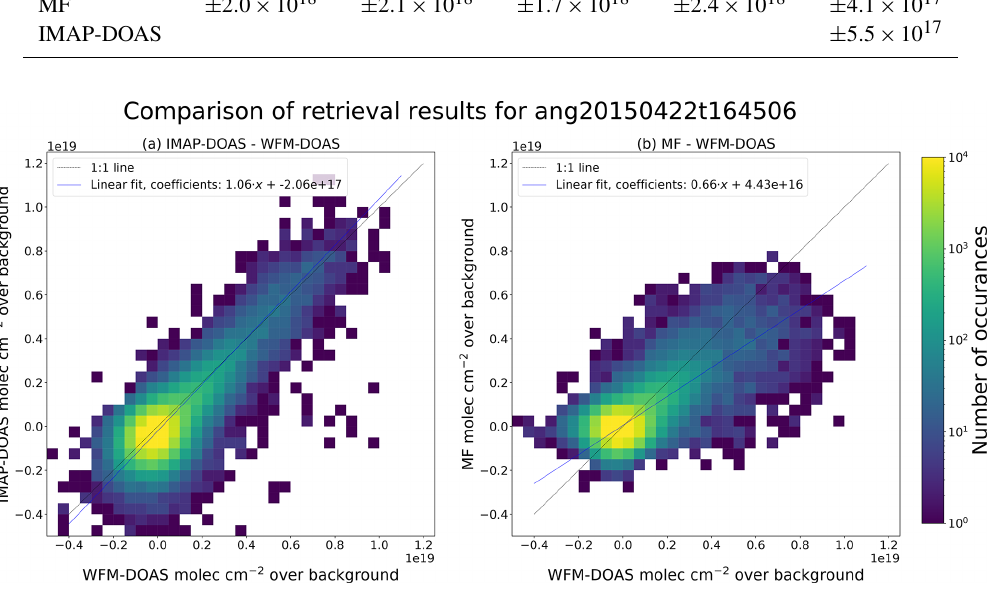
Figure 11. Scatter plot comparison between IMAP-DOAS and WFM-DOAS (a) and MF and WFM-DOAS (b) , respectively, for the coal mine ventilation shaft